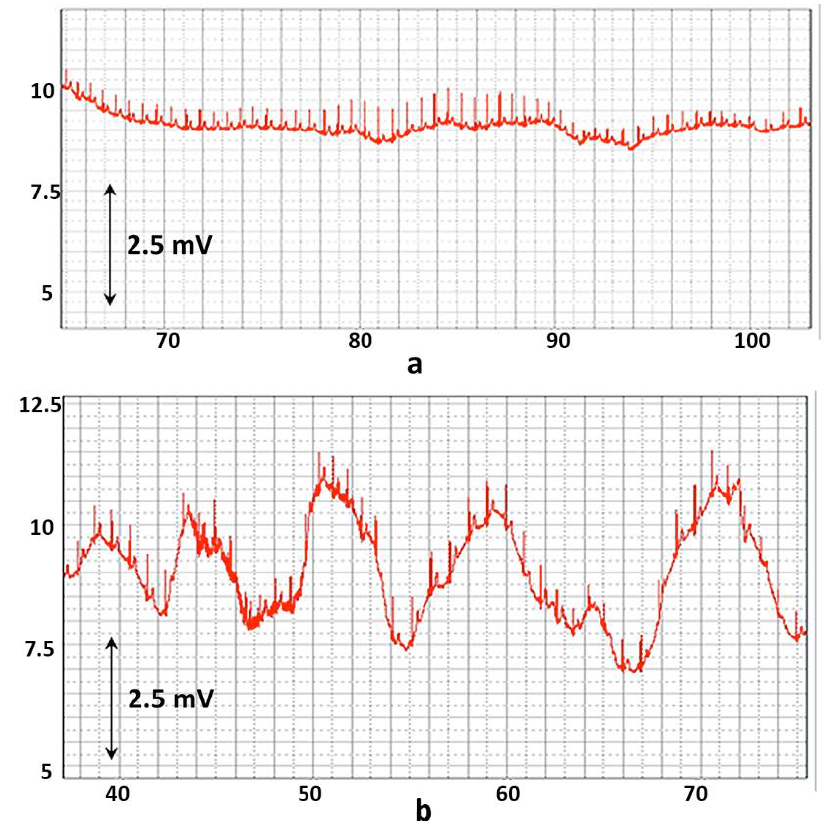
Figure 11. ECG of the examined patient with: ( a ) 8.8 mm, ( b ) 5.8 mm.